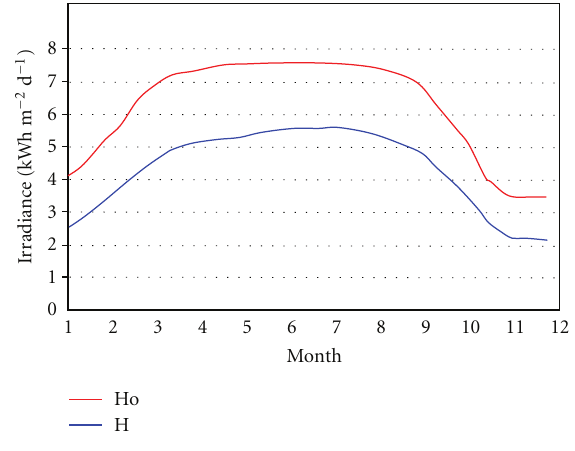
Figure 10: Solar irradiance for Syracuse,